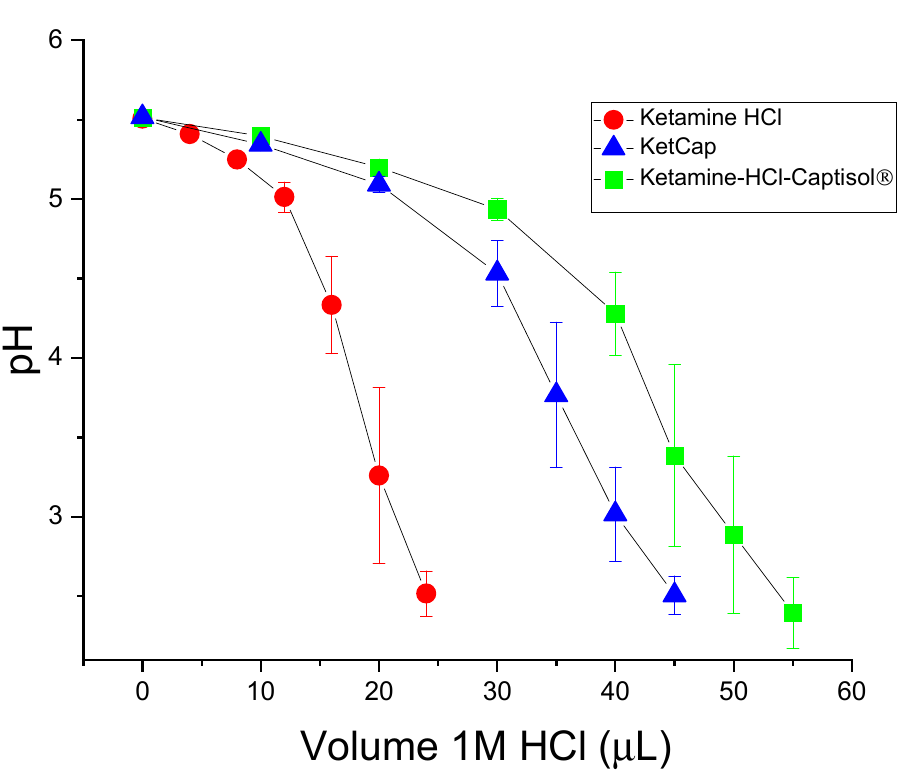
Figure 3. Titration of 100 mg/mL Ketamine, KetCap, and Ketamine-HCl-Captisol ® Formulations with 1M HCl. Starting pHs 5.50 ± 0.01. Experiments carried out on a 2 mL volume. Data presented as mean ± SEM. N = 3.